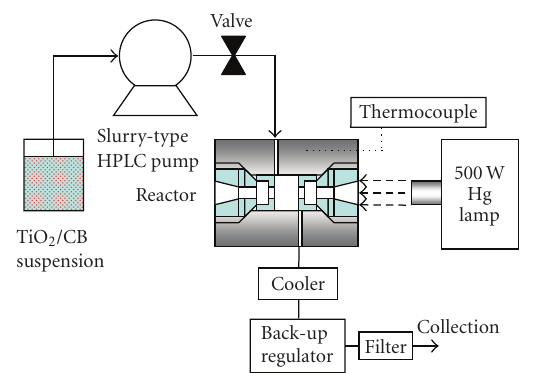
Figure 1: Schematic diagram of the fluidized-bed-type reactor de- signed for the study of photocatalytic reactions of TiO 2 suspension under high-temperature, high-pressure